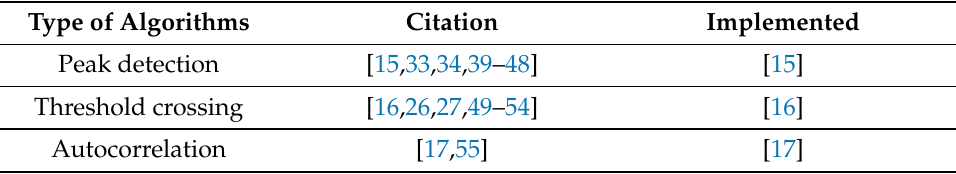
Table 2. Summary of algorithms published since 2004 and algorithms selected for testing.